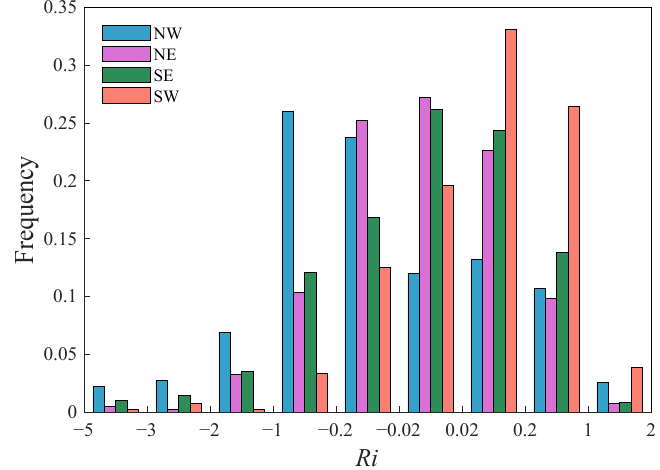
Figure 4. Distribution of the stratification stability Ri in each direction.